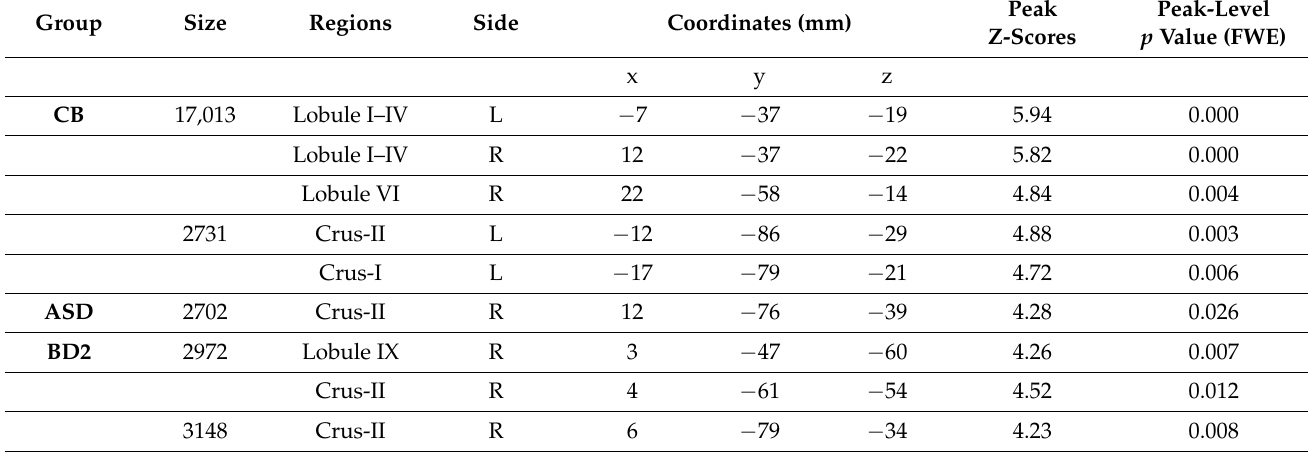
Table 3. Two-sample t-test showing regions of cerebellar GM reduction in CB, ASD and BD2 compared to